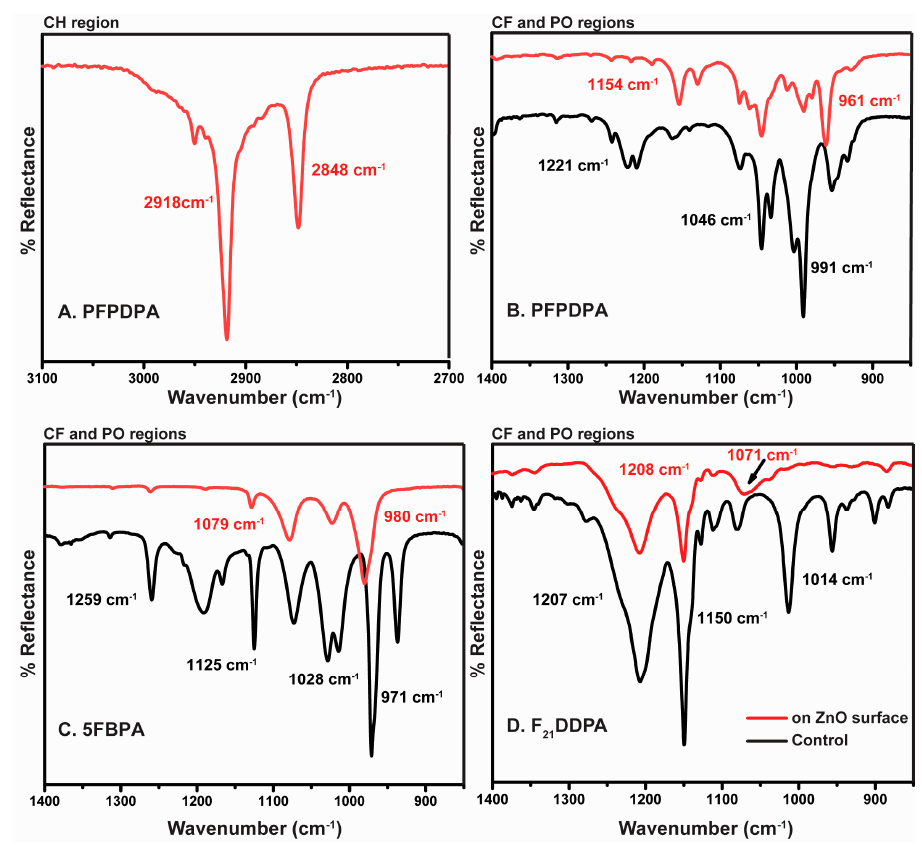
Figure 2. Infrared spectra of ZnO nanoparticles modified with ( A ) PFPDPA C–H region; ( B ) PFPDPA C–F and P–O regions; ( C ) 5FBPA C–F and P–O regions; and ( D ) F 21 DDPA C–F and P–O regions are displayed. The spectral regions occurred after rinsing and sonication (red spectra) compared to each control (black spectra).